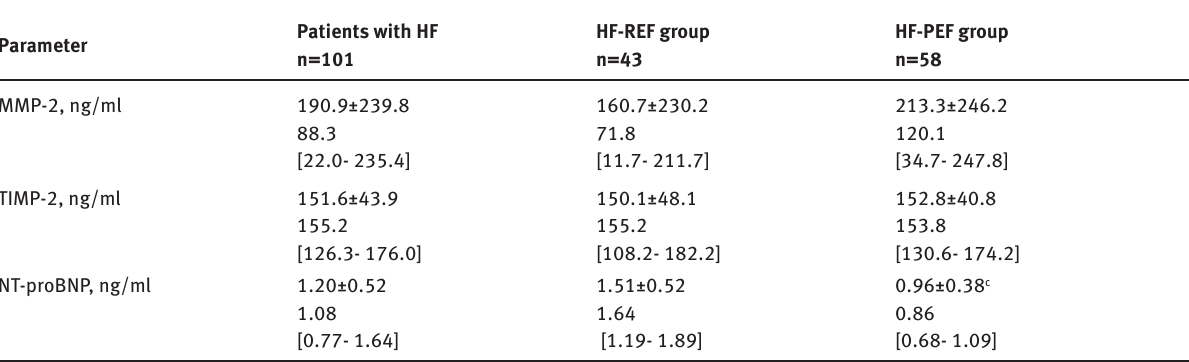
Table 2: The serum levels of MMP-2, TIMP-2 and NT-proBNP in patients with HF-REF versus HF-PEF (classification according to the level of ejection